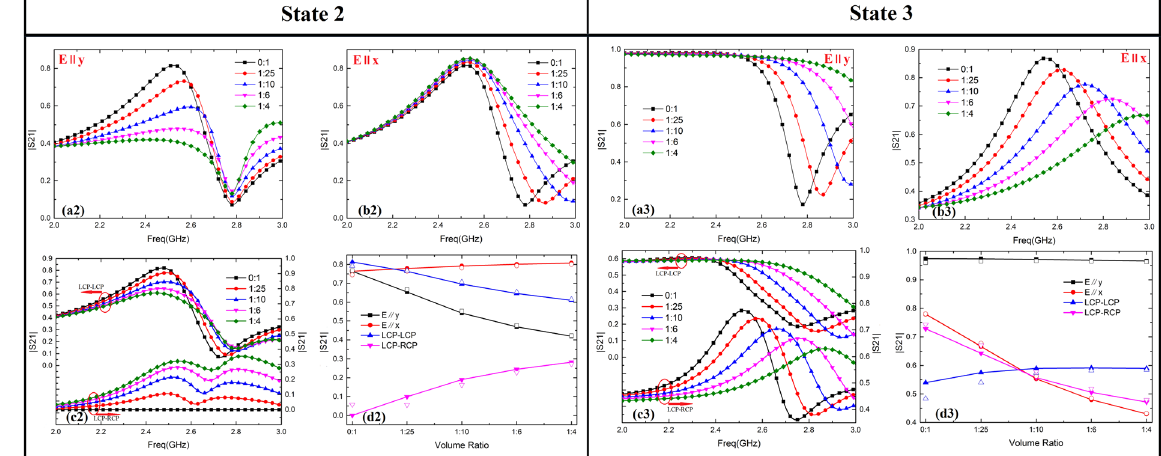
Figure 3. ( a2 , a3 ) Simulated transmissions of y-polarization for state 2 and state 3. ( b2 , b3 ) Simulated transmissions of x-polarization for state 2 and state 3. ( c2 , d2 ) Simulated conversions of LCP-LCP and LCP-RCP for state 2 and state 3. ( d2 , d3 ) Simulated (solid) and measured (open) magnitudes vary with volume ratio at 2.45 GHz for state 2 and state 3.